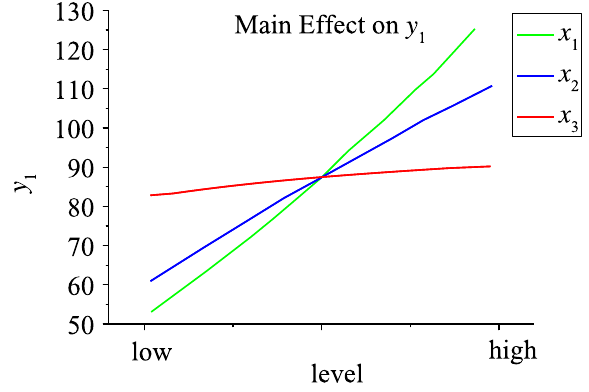
Fig. 12. Main effect for all design